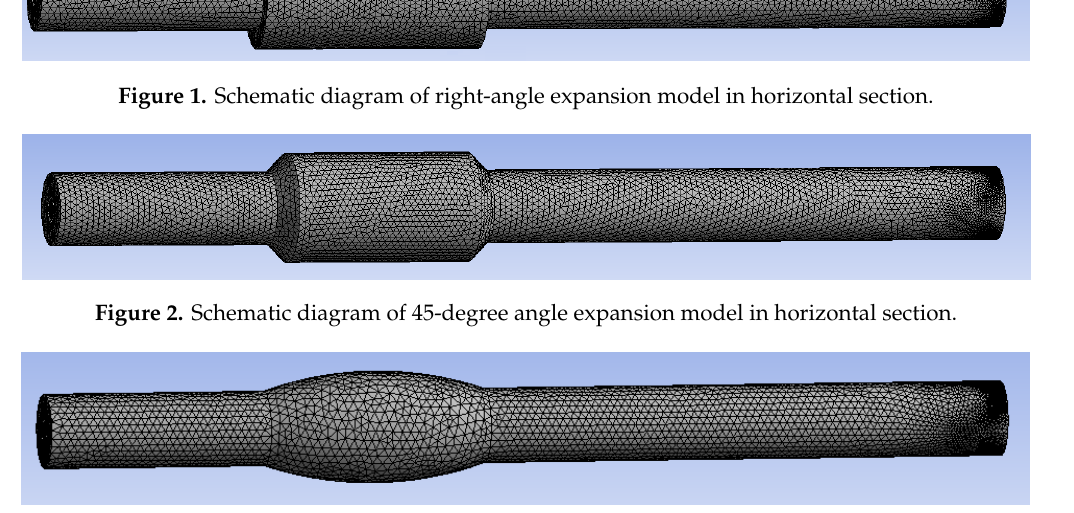
Figure 3. Schematic diagram of arc expansion model in horizontal section.